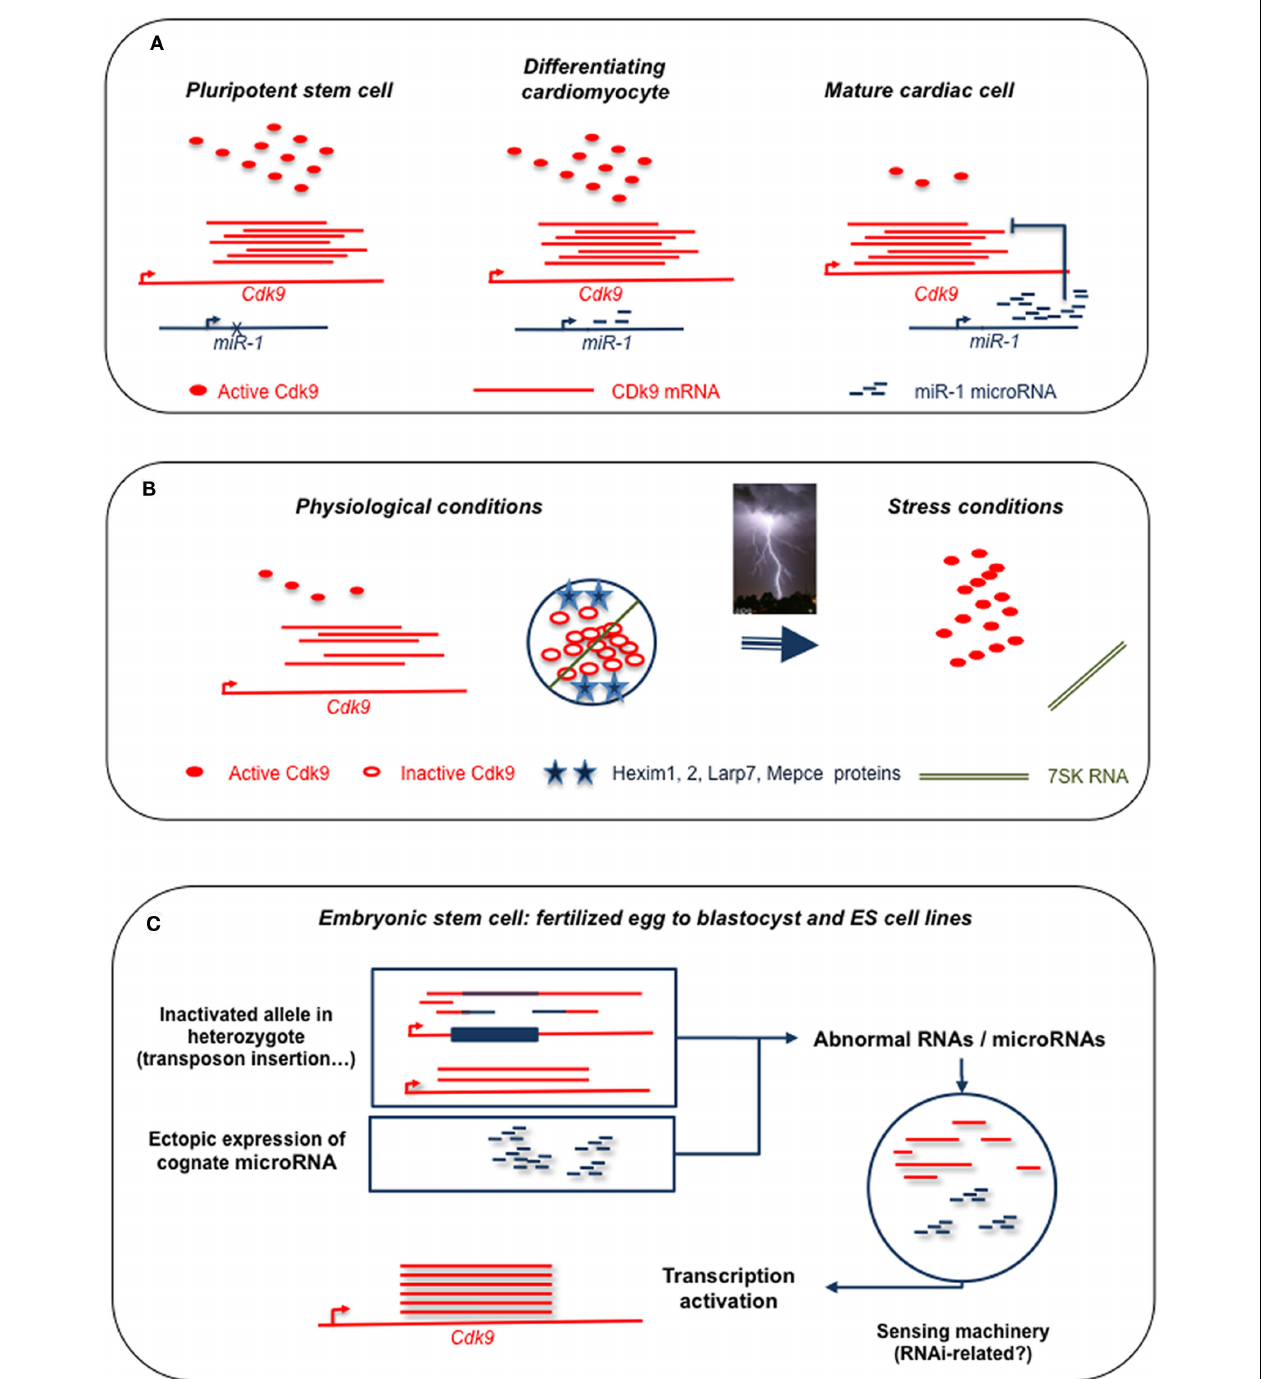
FIGURE 1 | Schematic representation of sncRNA-mediated regulations of Cdk9 expression. (A) Down regulation by microRNA miR-1 of Cdk9 translation in differentiated cardiomyocytes following the high levels of expression required during the differentiation process. (B) Storage of inactive protein in a complex with 7SK RNA and inhibitory proteins, release of active kinase in stress conditions. (C) Summary of our current observations on the initiation of paramutation. Observed either in heterozygote genotypes with one allele disrupted by insertion as in the case of Kit ∗ paramutants (Rassoulzadegan et al., 2006) or